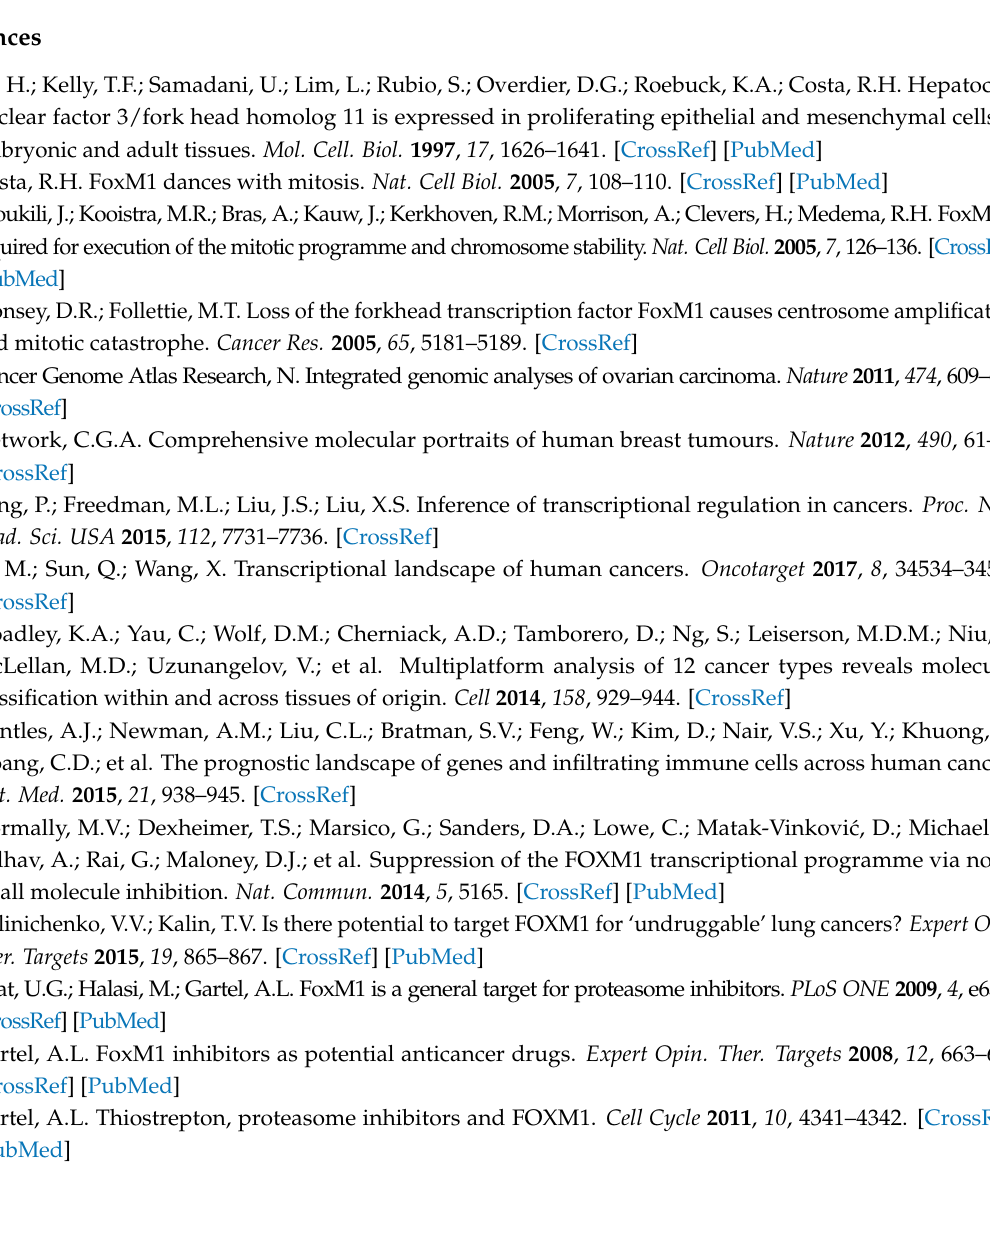
lines, Table S3: RNA-seq differential expression analysis related to Figure 9C–F, Table S4: Lists of genes in Venn Diagram related to Figure 9E, Table S5: Lists of genes in Venn Diagram related to Figure 9F, Table S6: Lists of primers and